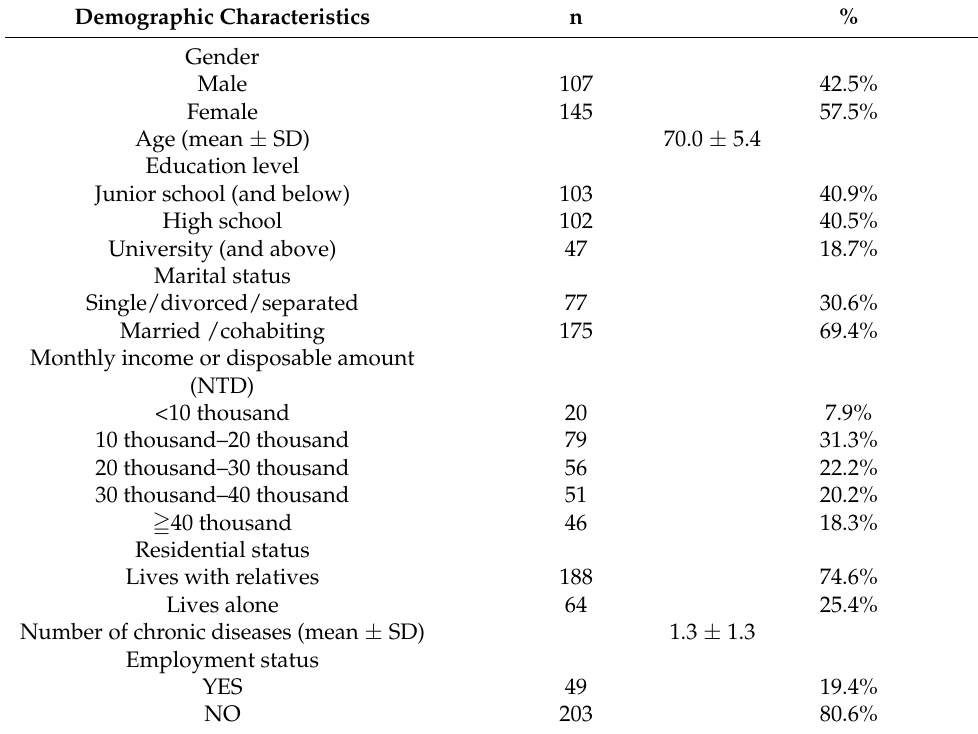
Table 1. Demographic characteristics of the participants (N =